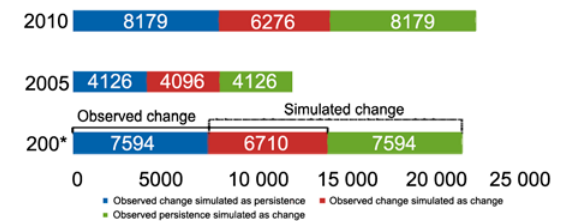
Fig. 8. Quantities of correct and errors values in the model validation